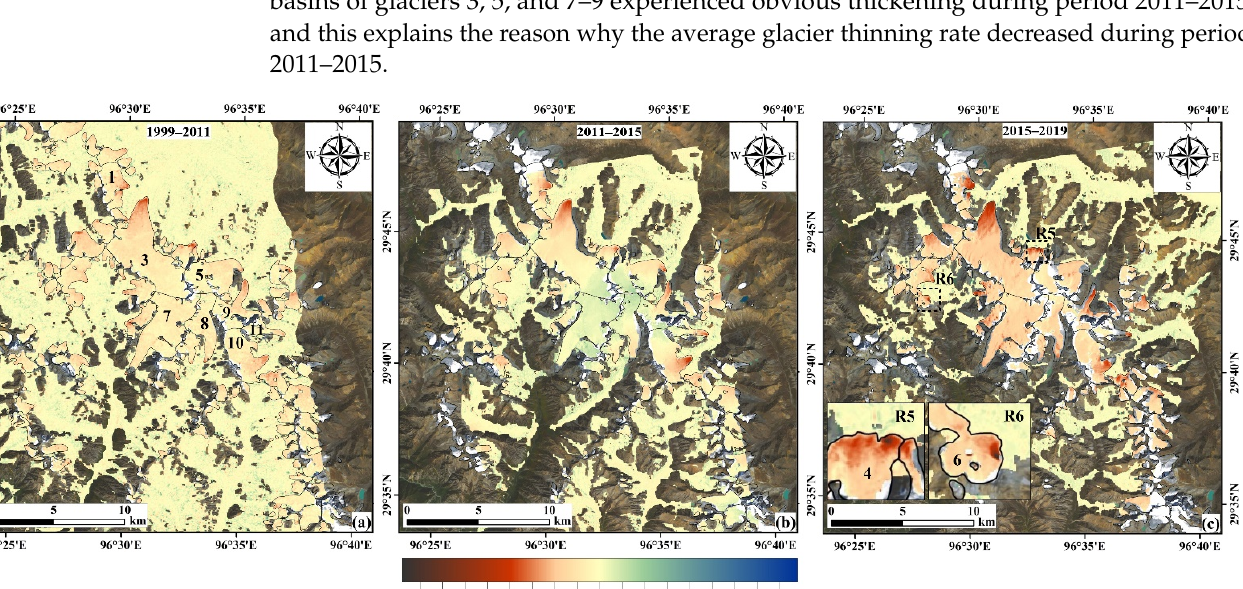
Figure 4. ( a ) Glacier area and average glacier elevation change rate (AGECR) in each 50 m altitude band, and ( b ) the uncertainty of corresponding AGECR. The AGECRs in different observation pe- riods are denoted by different symbols. The uncertainty of AGECR in each altitude band was esti- mated based on the NMAD of the elevation change rate in stable areas (see Section 4.4). The last two altitude bands have no elevation change rate observations in stable areas, and the uncertainties of the AGECRs in these two altitude bands were assumed to be the same as that of the last but two.